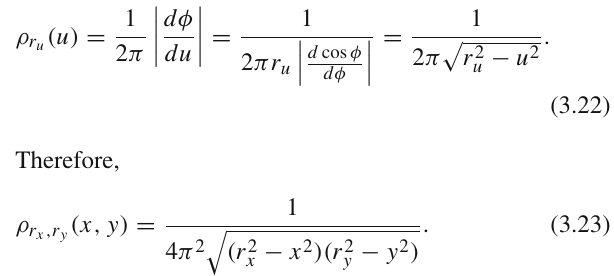
Fig. 6 Left: the trajectory of one particle with r x = 20, r y = 30 µ m followedduring5000turnsinthepresenceofthebeam–beamforce.The bunch parameters are from Table 1 except the tunes. The black points are obtained with Q x = 0 . 3, Q y = 1 / 3. The red points, scattered in the background,aresimulatedwith Q x , Q y shiftedby + e − 8 . 5 / 4 , − e − 8 . 5 / 4, respectively. Right: the probability density of x – y localization of the particle followed during 10 6 turns